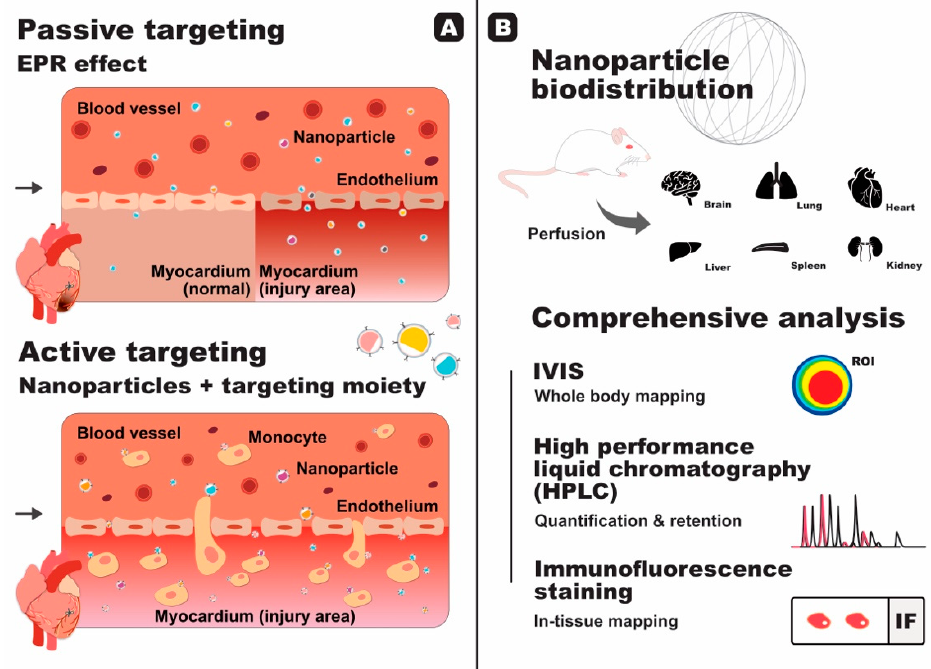
Figure 1. The use of functionalised nanoparticles for the treatment of cardiac ischaemic injury: ( A ) Passive targeting via the enhanced permeability and retention (EPR) effect in comparison to active targeting, using nanoparticles decorated with targeting moieties. Nanoparticles bearing monocyte-targeting moiety are able to actively attach onto the surface of monocytes and extravasate into the injured area; ( B ) Nanoparticles biodistribution study is indispensable in order to investigate the fate of nanoparticles in vivo. Perfusion is performed to rid the organs of freely circulating nanoparticles in the blood prior to organ collection. Overall, biodistribution study maps out the distribution of nanoparticles throughout the body and within the tissue. It also shows the amount retained in each tissue, providing researchers with a complete overview of the fate of their nanoparticles.